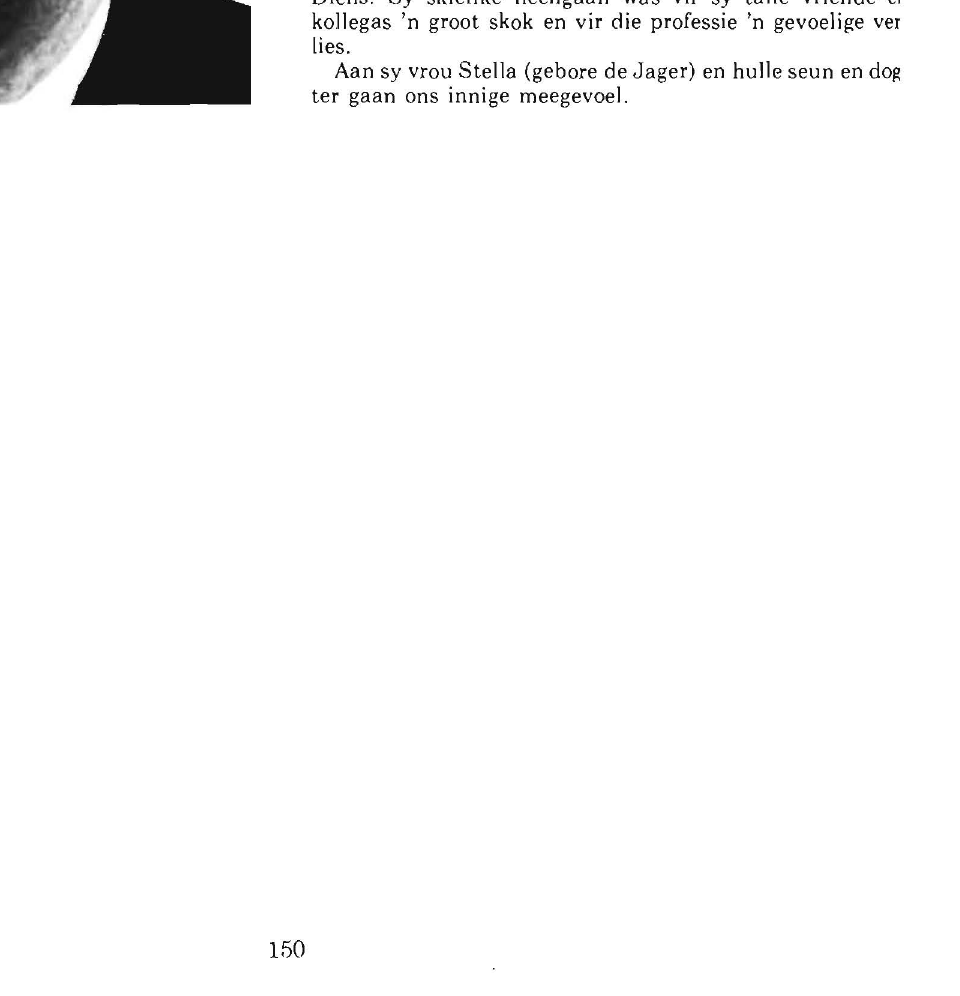
vinding, kundigheid en werksvermoe was hierdie eien skappe dan ook verantwoordelik vir sy vordering in di, Diens. Sy skielike heengaan was vir sy talle vriende el kollegas 'n groot skok en vir die professie 'n gevoelige vel lies. Aan sy vrou Stella (gebore de Jager) en hulle seun en dog ter gaan ons innige